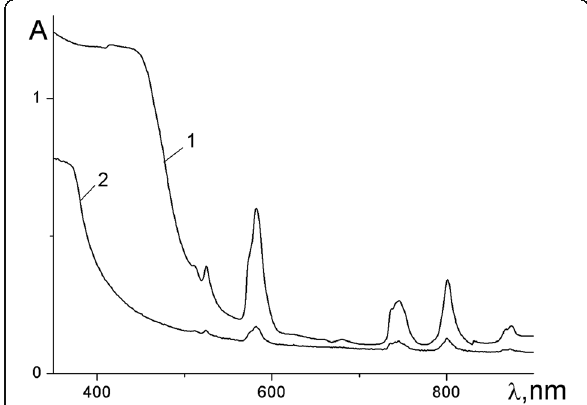
Fig. 3 Absorption spectra of ( 1 ) Nd(mphpd) 3 and ( 2 ) [Nd(mphpd) 3 ]